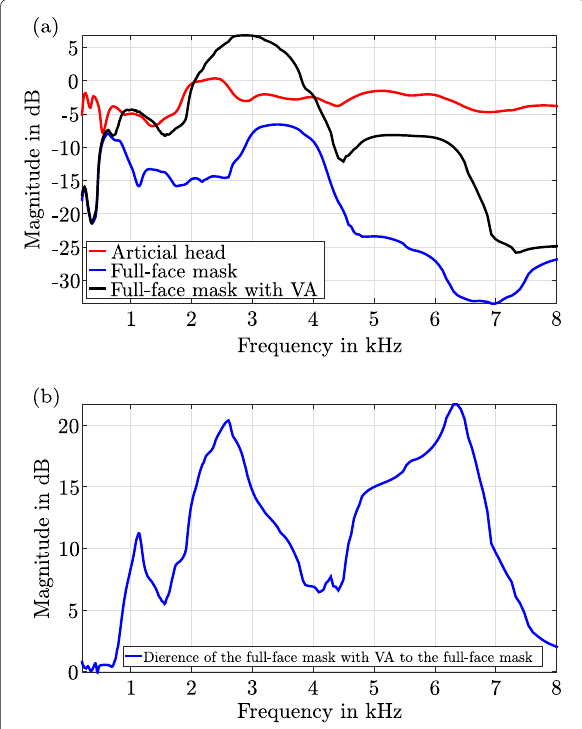
Fig. 17 Evaluation results. a Power spectral densities of the full-face mask FPS 7000 without a communication system(blue), with an activated voice amplifier of the communication system FPS-COM 7000 (black), and the artificial head without a full-face mask (red). b Difference of the power spectral densities from the full-face mask FPS 7000 with an activated voice amplifier of the communication system FPS-COM 7000 to the full-face mask FPS 7000 without a communication